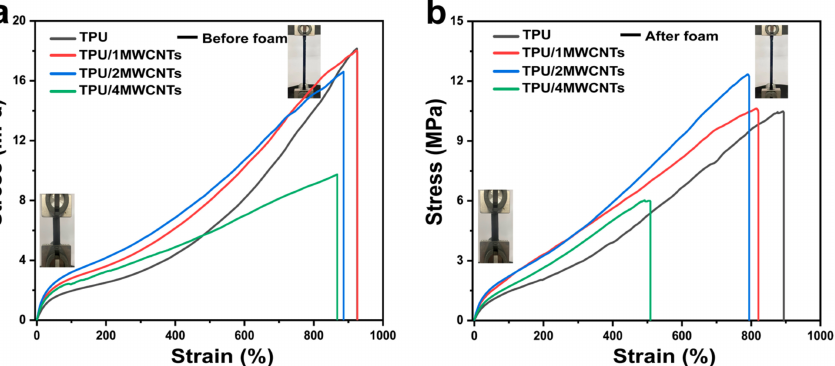
Figure 3. ( a , b ) Tensile stress-strain curves of TPU and TPU/MWCNTs composites with different MWCNTs content (0, 1, 2, 4 wt%) before and after foaming (Loading speed: 50